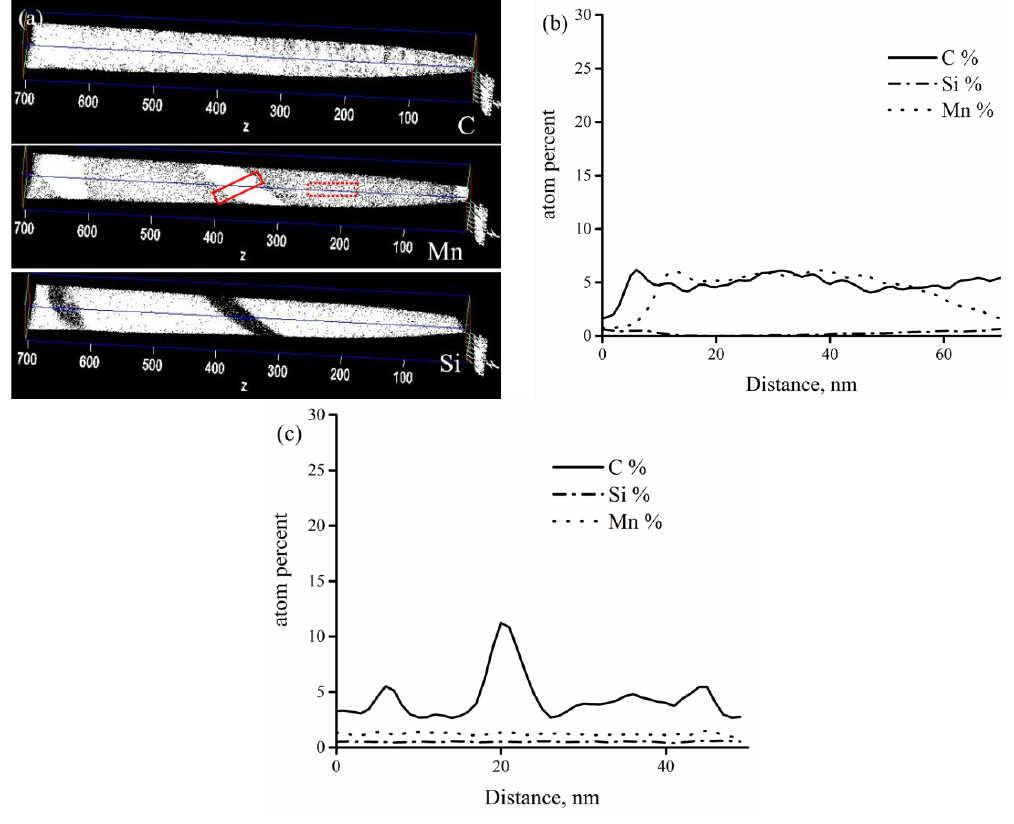
Figure 13. The 3D element maps of an APT needle taken in WEL, ~10 μm the beneath rail surface ( a ) and the composition profiles of regions enclosed in the solid rectangle and the dotted rectangle in ( a ) are shown in ( b , c ), respectively.